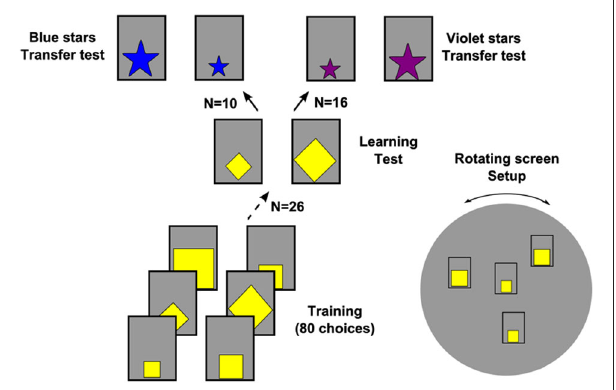
FIGURE 2 | Training and testing procedure . The bees had to choose between stimuli varying only in size. At each foraging bout, the bees faced stimuli of two different sizes taken randomly between the six available sizes (from 1 to 6 cm with 1 cm step). Depending on testing group, the smallest or the largest stimuli were rewarded with a sucrose solution while the alternative stimuli were associated with a quinine solution. Each stimulus was presented twice. Four stimuli (two identical S+ and two identical S − ) were then simultaneously offered to the bees. During training, stimuli shapes and size combinations varied to facilitate concept learning. Once training was completed, the bees were subjected to non-rewarded transfer tests intermingled with refreshing training trials. Note that only a subset of all possible tests was proposed to each bee (see text for details). The insert show a representation of the rotating screen on which the four stimuli are vertically presented in a random spatial organization (Dyer et al.,